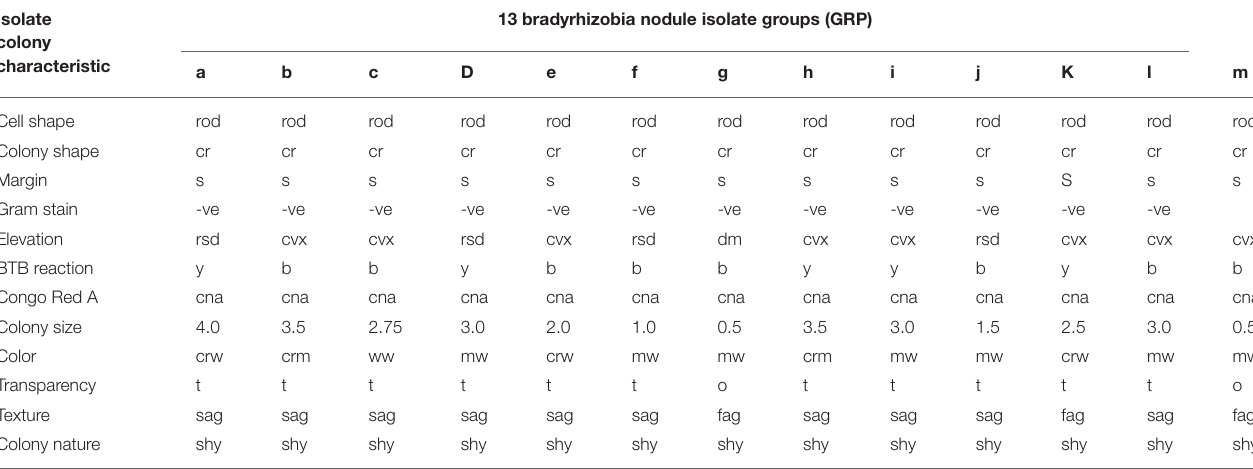
TABLE 3 | Colony characteristics of indigenous bradyrhizobia isolates obtained from soybean nodules from organic and conventional farms. Isolate colony characteristic